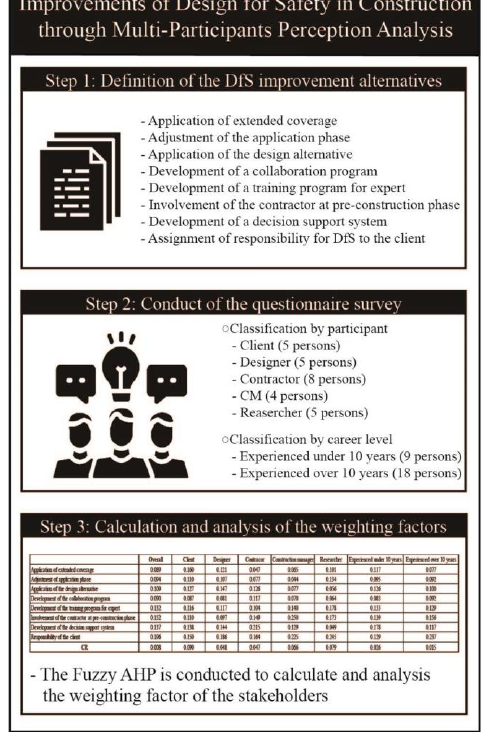
Figure 1. Research